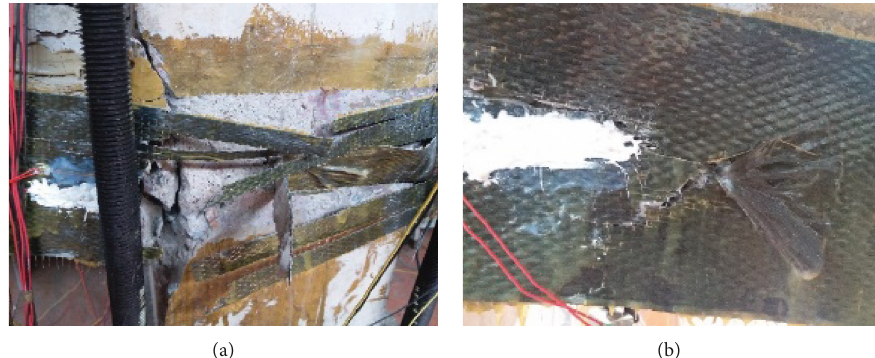
Figure 7: CFRP failure characteristics of the strengthened specimen near the middle column in CA. (a) CFRP debond and fracture. (b) CFRP debond.